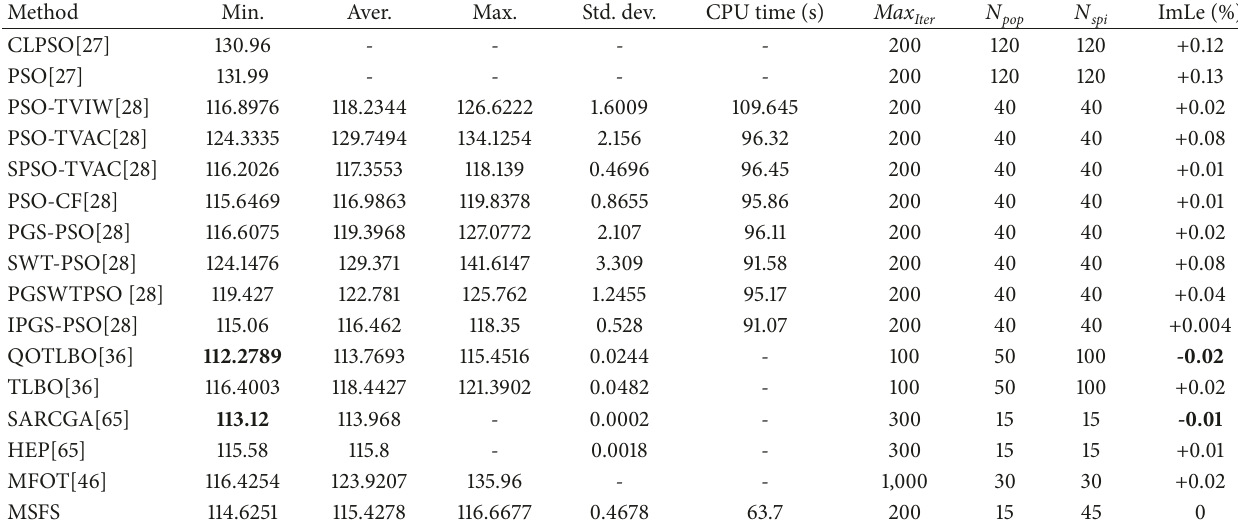
Table 8: Comparison of results obtained from IEEE 118-bus system with power loss optimization.